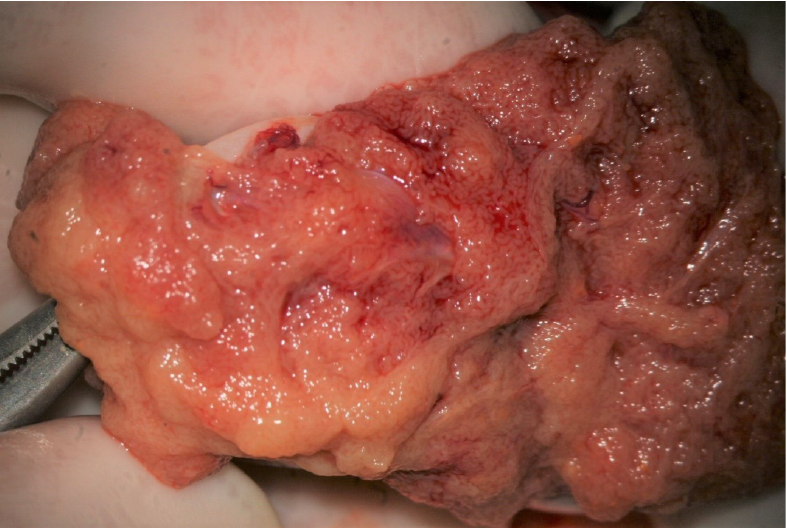
Figure 6. Extremely wide testis opening with exploration in the bi-polar direction and partial extrusion of lobules.